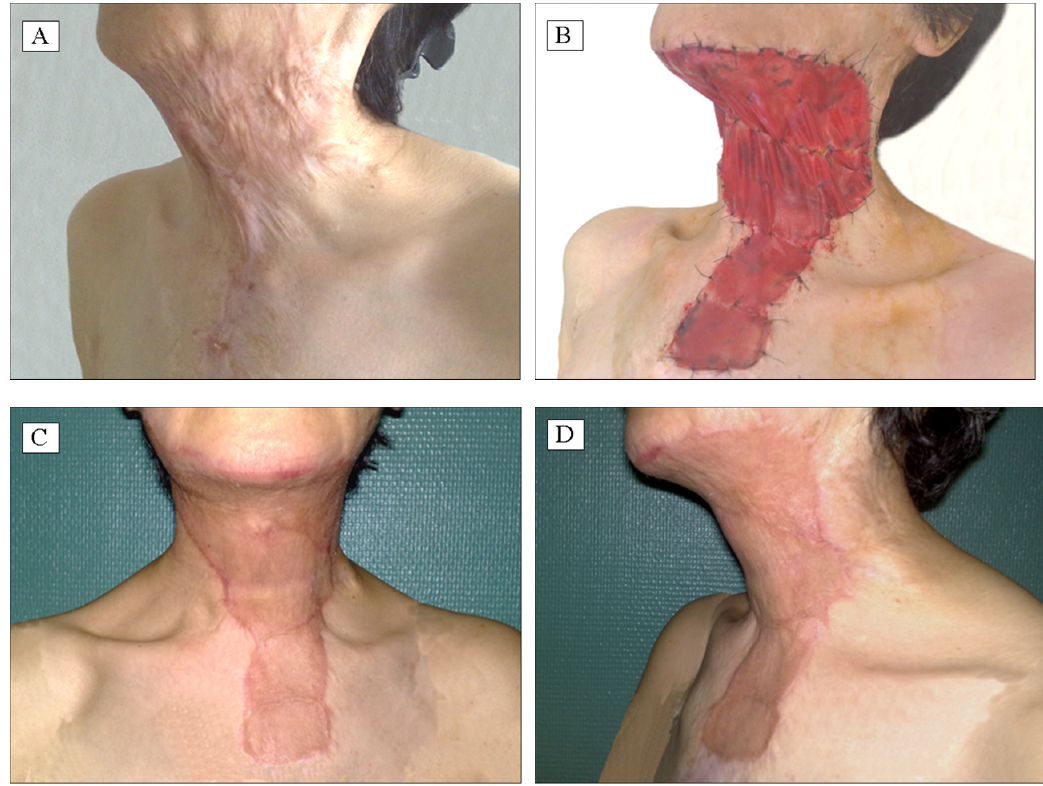
Figure 4. Case 4. A 50-year-old female patient su ff ered eleven years ago a 30% burned surface, flame burn, IInd-IIIrd degree (cervical region, anterior thorax, upper limbs): ( A ) Image of neck scar prior reconstruction with Integra; ( B ) image of the neck, 10 days after reconstruction with Integra; ( C ) skin neck reconstruction with Integra, after 3 months, frontal view; ( D ) skin neck reconstruction with Integra, after 3 months, lateral